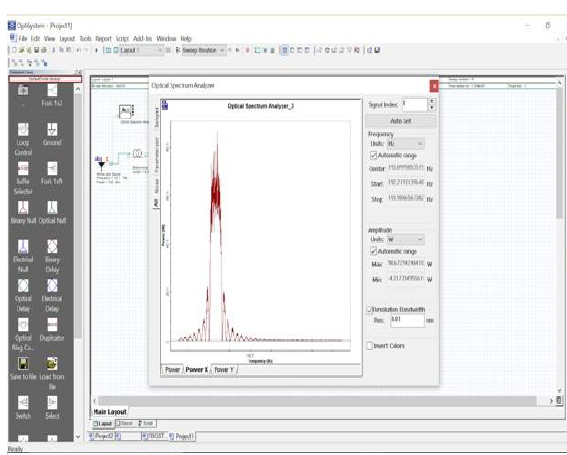
Fig. 5. Power spectrum of transmitted signal